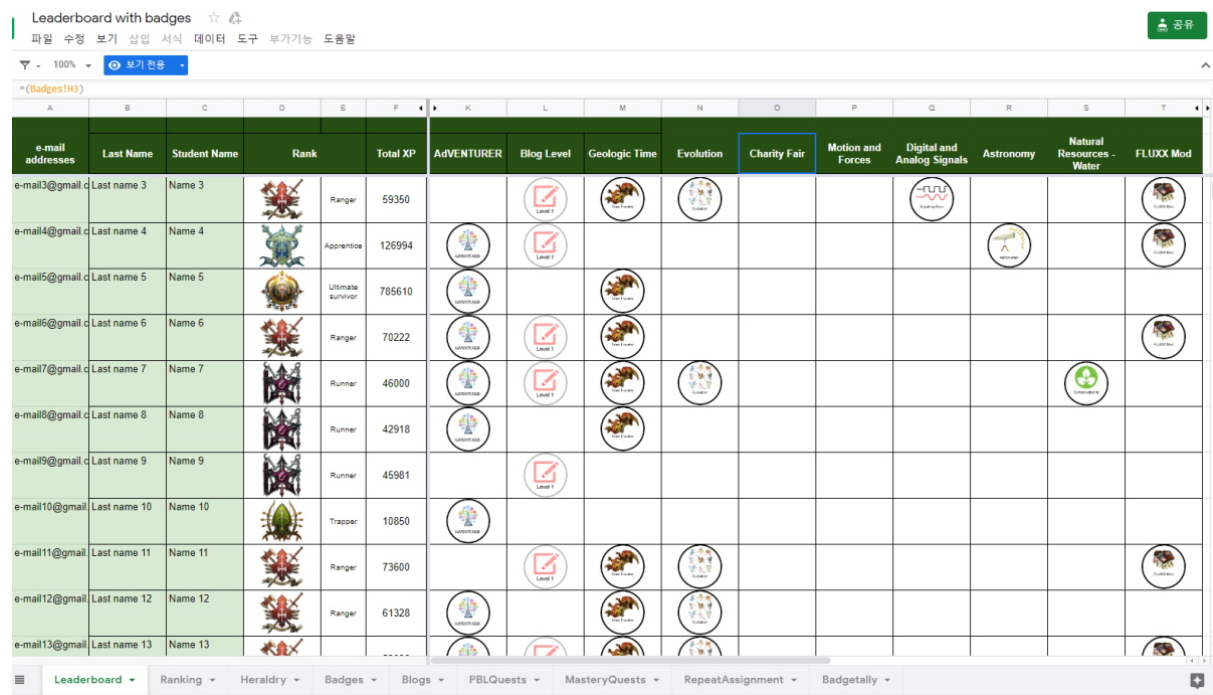
Figure 7. Leaderboard provided by Teaching Above the